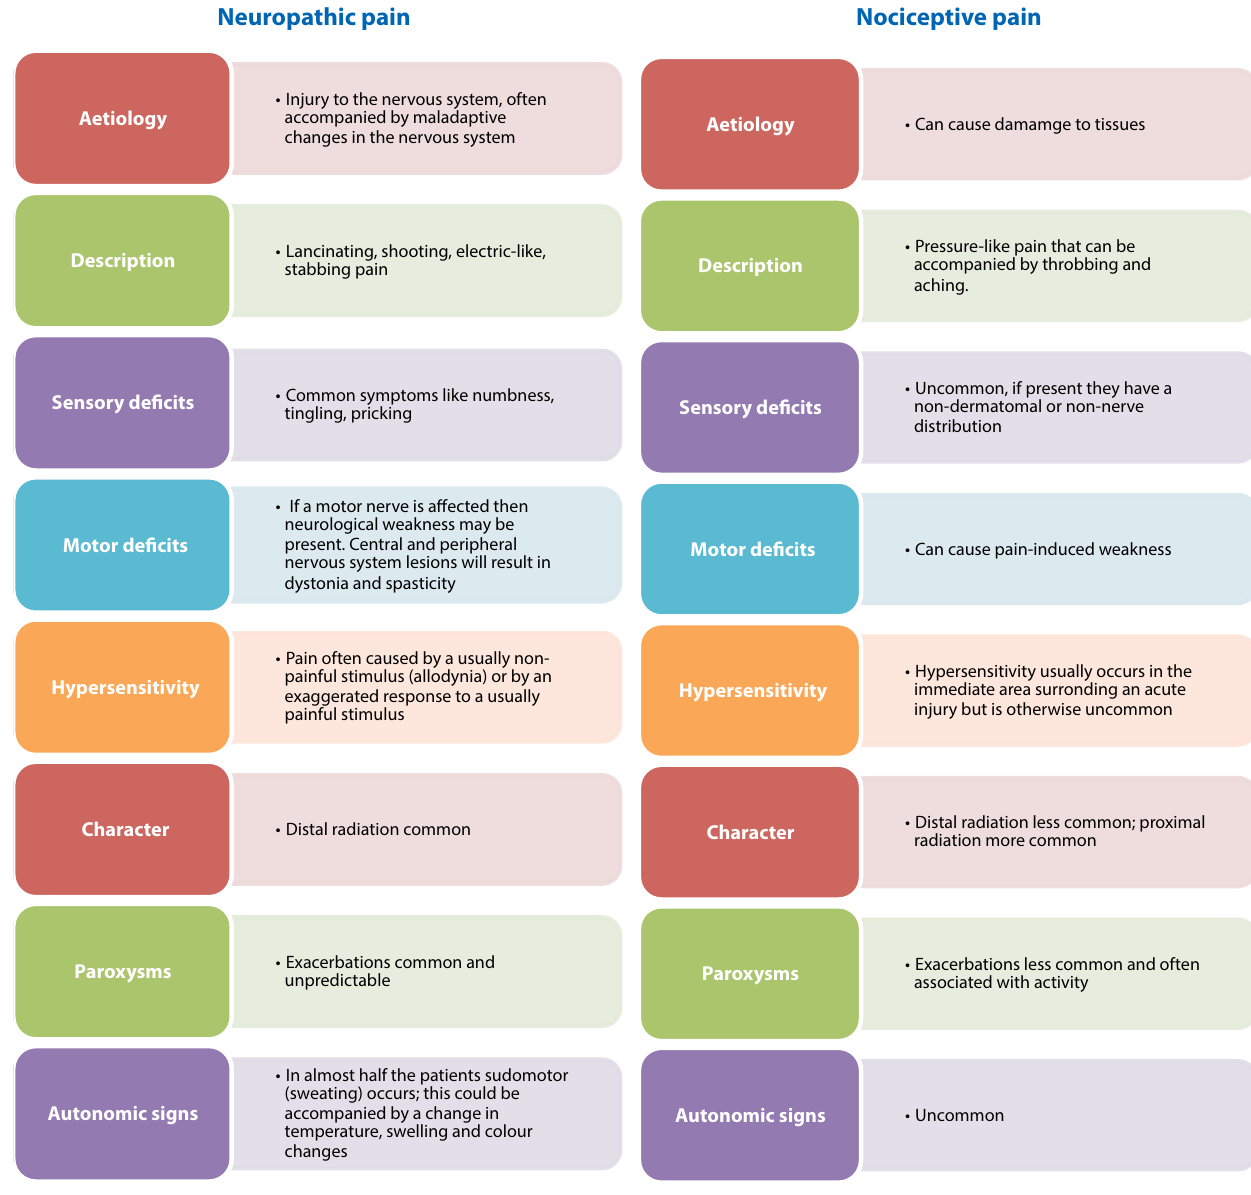
Table I: Classification of neuropathic and nociceptive pain